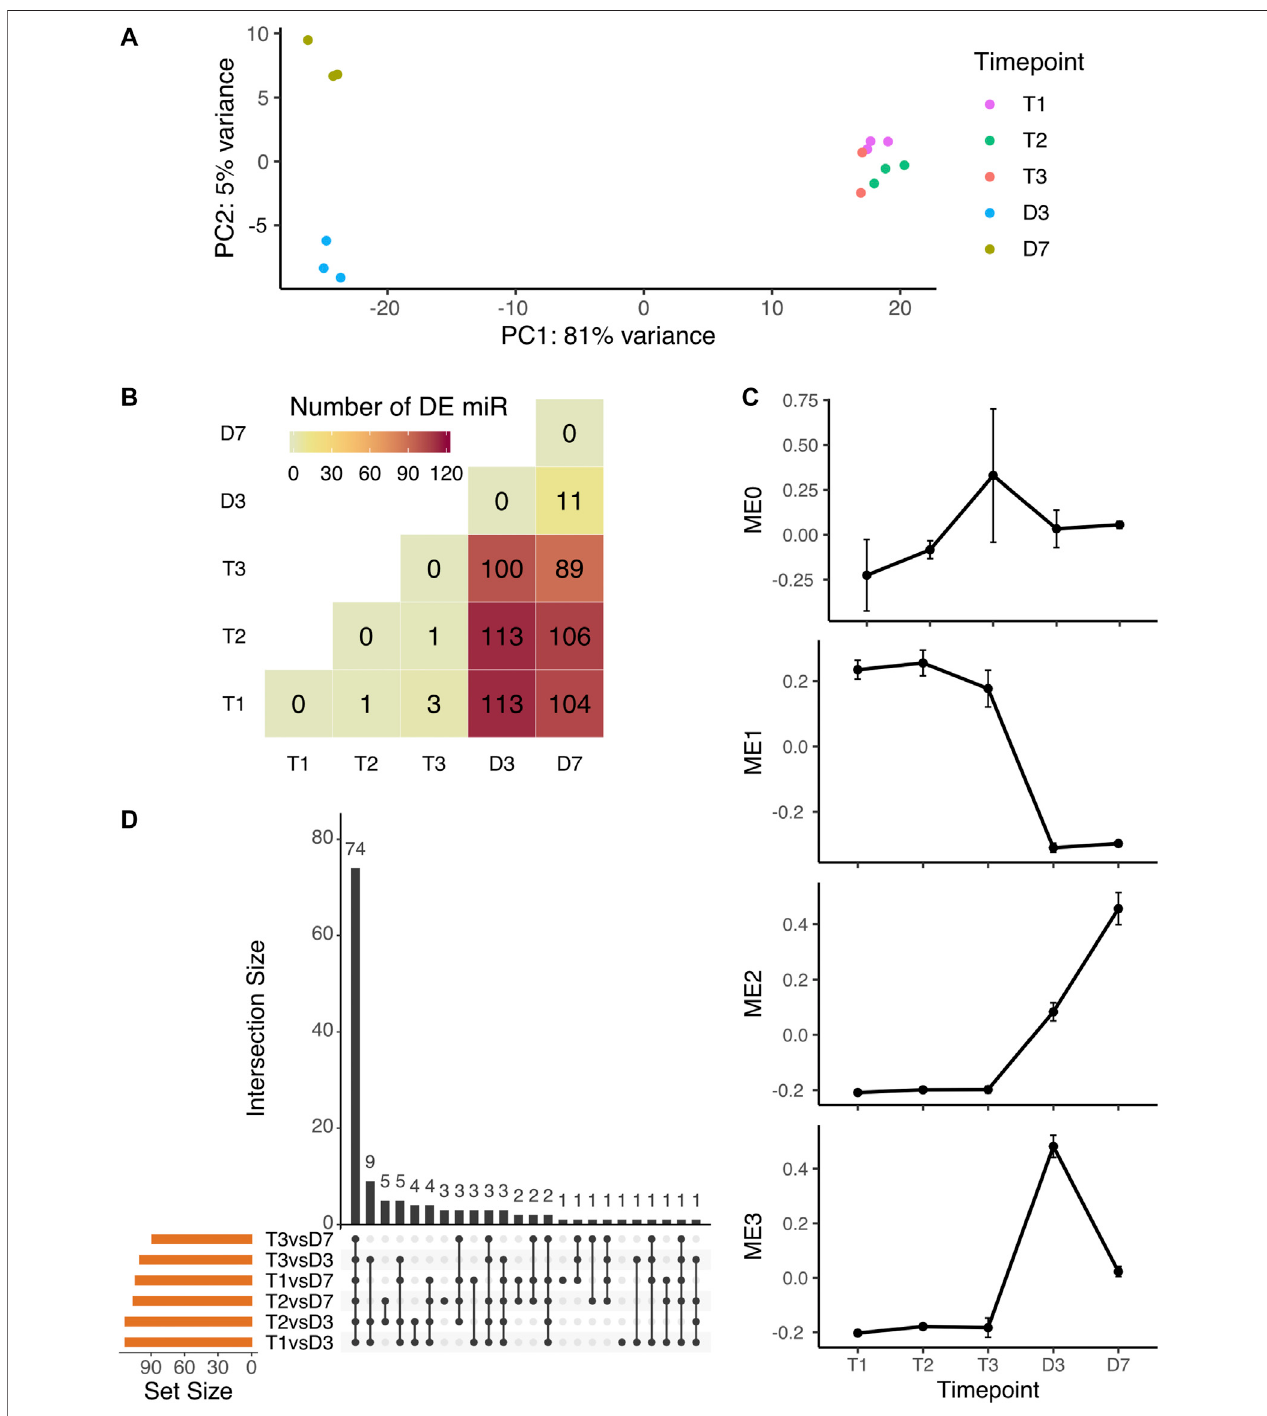
FIGURE2| Expression variationofmicroRNA duringpeachbud dormancy release (A) PCA analysisofmicroRNA expression over fi vetime points indormancy (B) ThepairwisecomparisonindicatesthenumberofdifferentiallyexpressedmicroRNAdetectedbyallstatisticaltests(all-by-allcomparisonof fi vetimepoints).Themajority of detected DE miRNAs werefrom the sixcomparisonswith adormant stage compared toa budbreakstage (C) Speci fi cally forthe tests comparingdormancy (T1, T2, and T3) to bud burst (D3 and D7) time points, the same miRNAs were often identi fi ed in multiple tests. The miRNAs shared across different combinations of statistical tests are indicated by the black dots (tests) and black bars (number of shared miRNAs) (D) The expression pro fi les of the module eigengene (mean ± SE), i.e. the overall expression pattern representing the genes in the module, from each microRNA co-expression module identi fi ed by WGCNA.